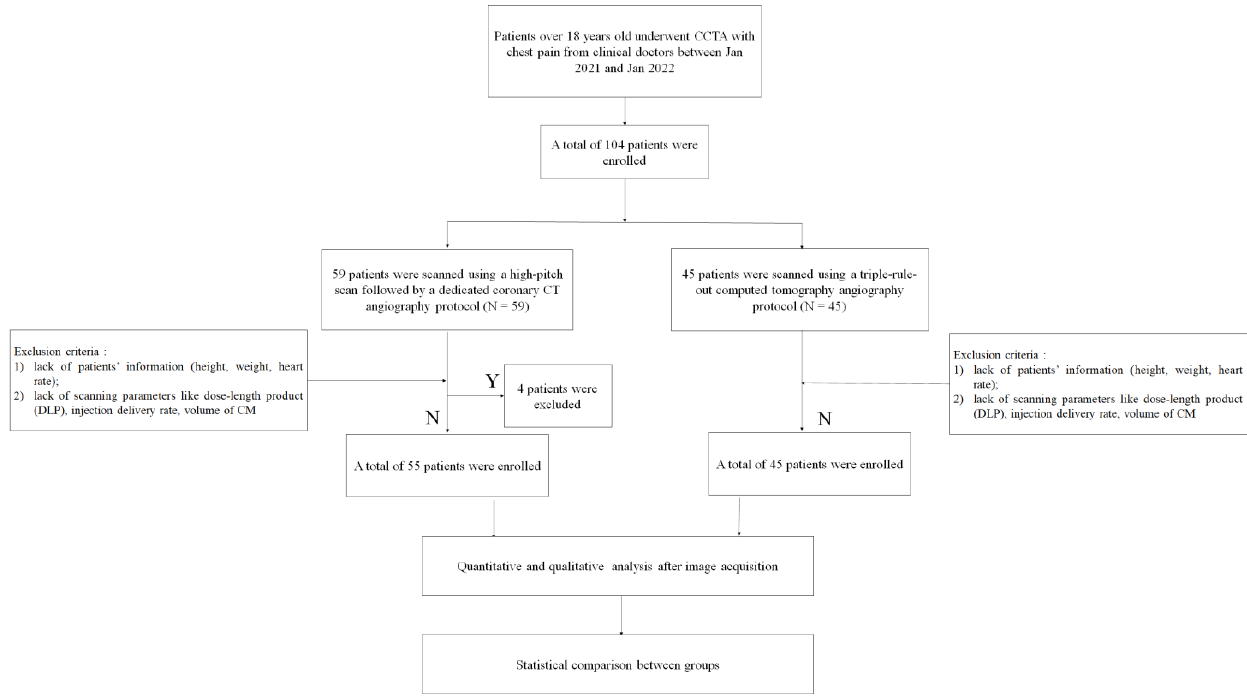
Figure 1. Flowchart of patient enrolment.